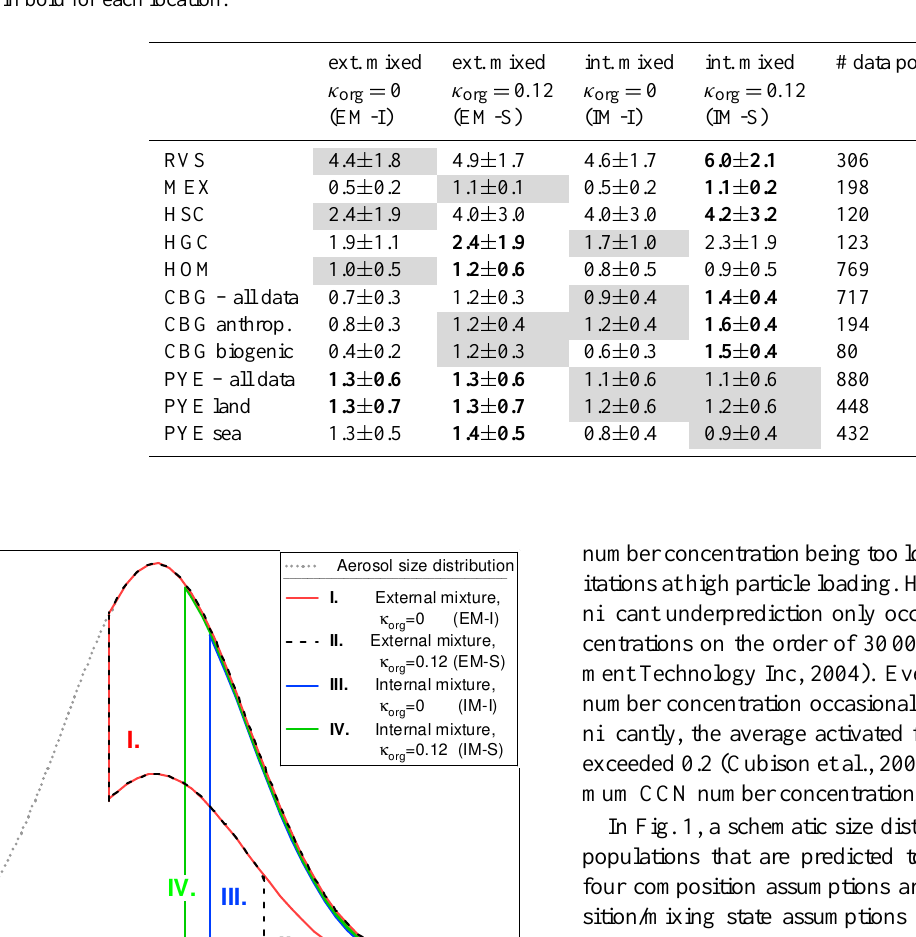
Table 2. Average ratios ( ± 1std dev) of calculated to measured CCN number concentrations for several locations and four different as- sumptions of composition/mixing state ( κ org : hygroscopicity parameter of organic fraction). Best agreement is marked in gray shaded cells, poorest in bold for each location.